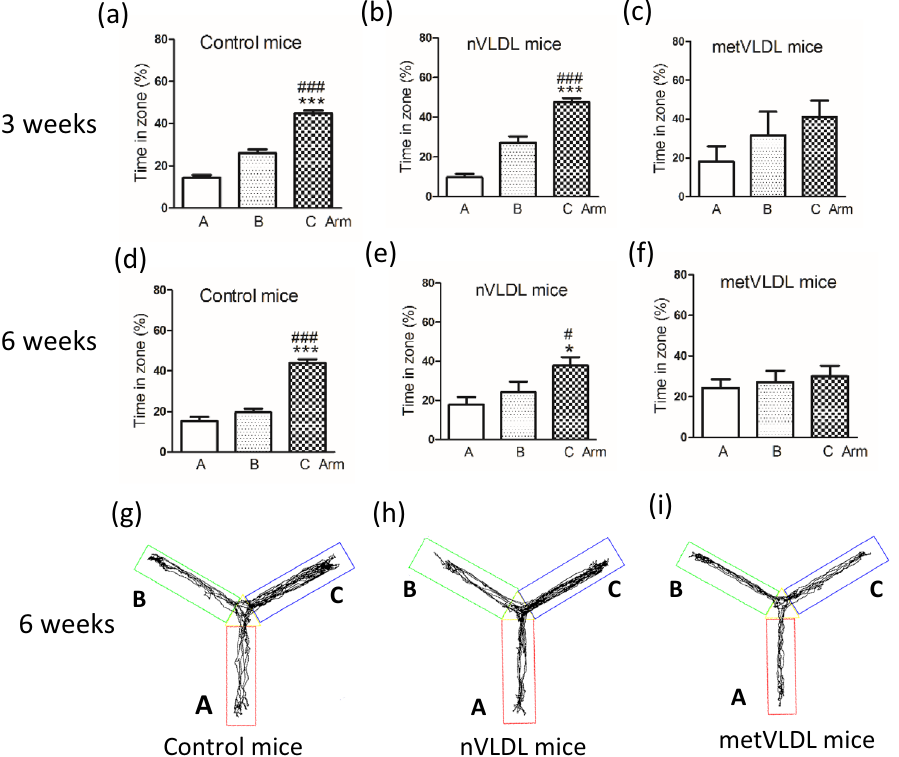
Figure 2. Y maze cognitive function test in mice. B6 mice were injected in the tail vein 3 times per week for 3–6 consecutive weeks with nVLDL (15 μg/g), metVLDL (15 μg/g), or an equivalent volume of saline (control). The percentage (%) of time spent in the start arm A, familiar arm B, or novel arm C after 3 weeks ( a – c ) or 6 weeks ( d – f ) of injections is shown for the indicated group. The moving track of control ( g ), nVLDL ( h ), and metVLDL ( i ) mice is shown, determined by using video-tracking software (Panlab Smart video-tracking software, version 3.0). Data are presented as the mean ± standard error of the mean (n ≥ 12 in each group). *p < 0.05, ***p < 0.0001 arm C versus A, #p < 0.05, ###p < 0.0001 arm C versus B within each group. P-values were determined by using one-way analysis of variance with the Newman-Keuls post-hoc test.